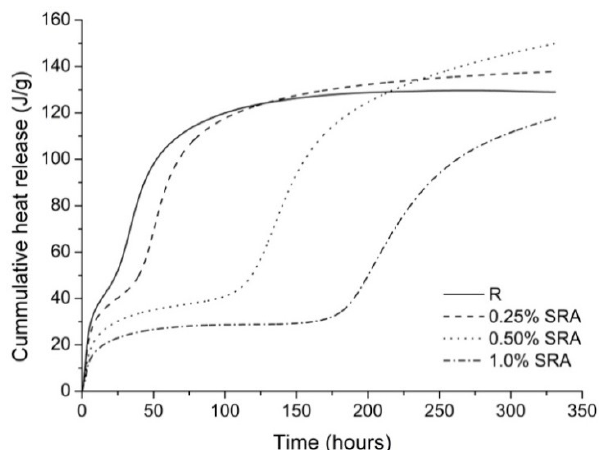
Figure 4. Effect of SRA on the total heat released during the hydration of AAS pastes.